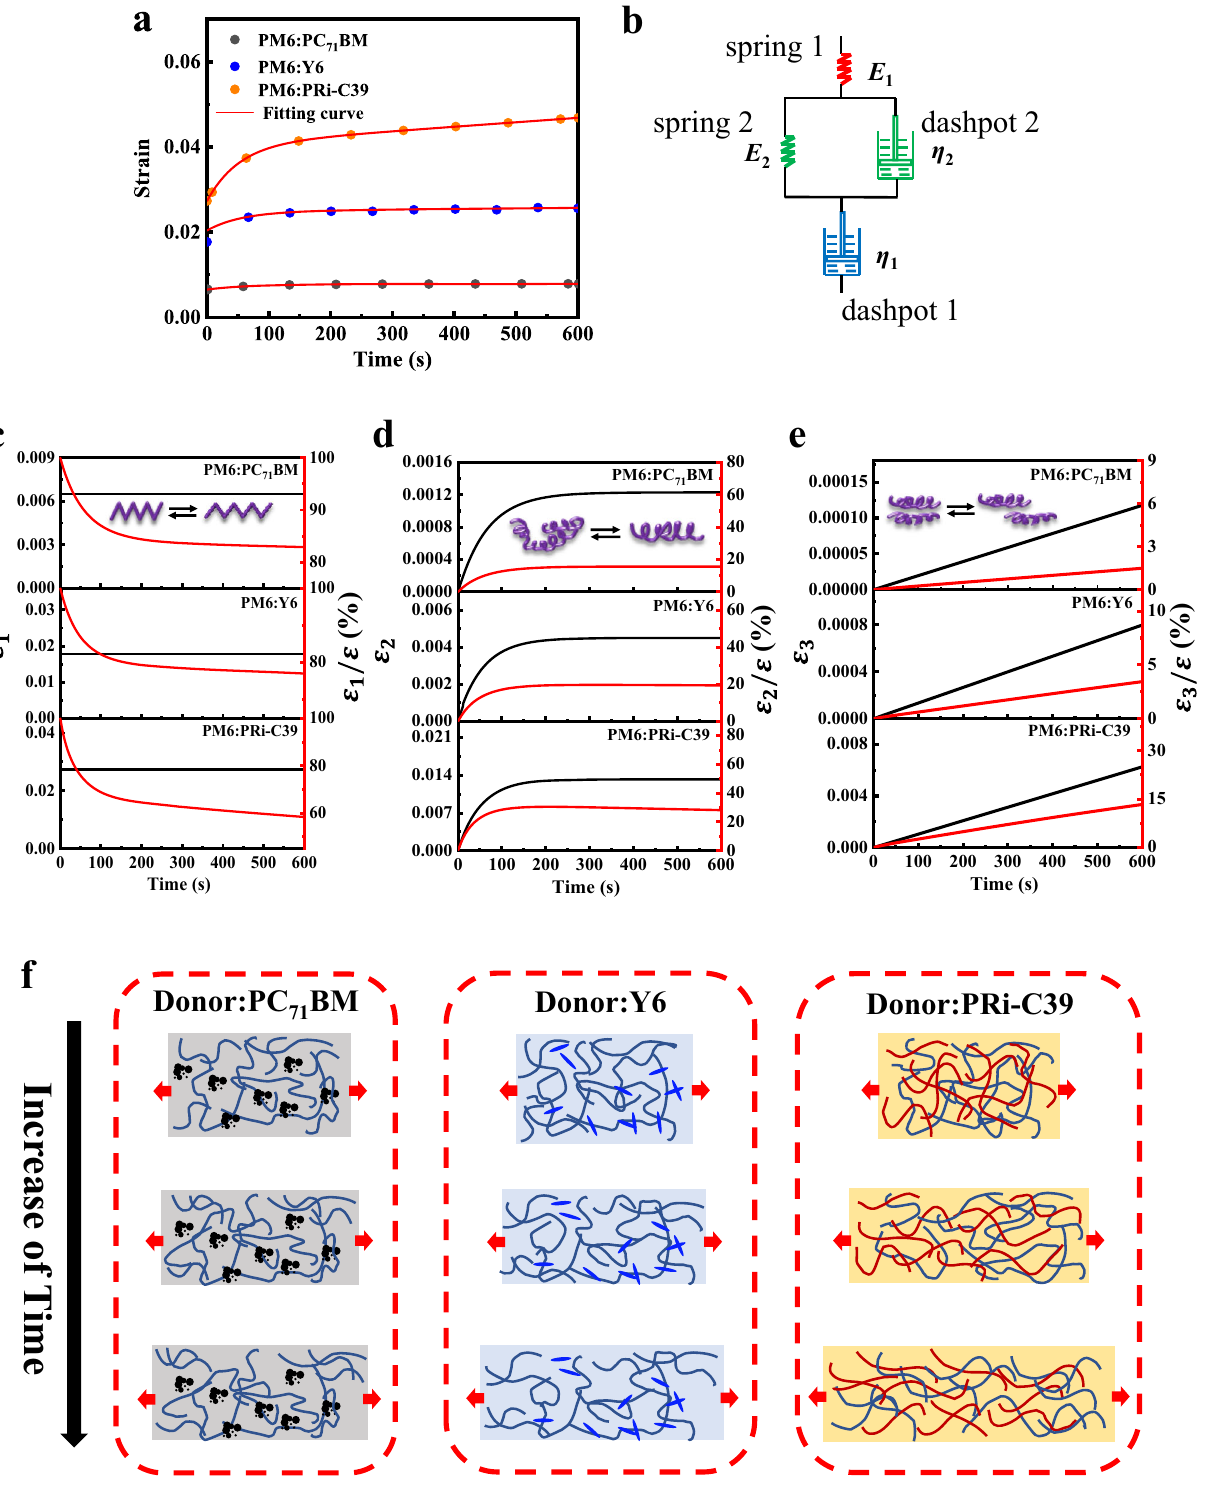
Fig. 2 Creep Behaviors of the BHJ Films. a Creep curves of the PM6-based blend fi lms with different acceptors under the same constant force. b Four-element viscoelastic model used to fi t the creep deformation. c ε 1 , d ε 2 and e ε 3 and their proportions in the total creep deformations versus creep time. Insets in c – e : Schematic diagram of the molecular movements. f Schematic diagram of creep deformation of the fi lms based on different